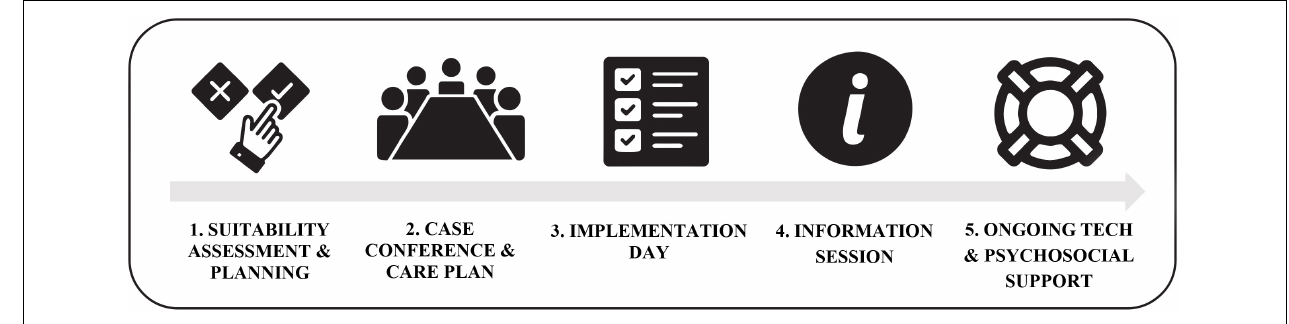
FIGURE 2 | Components of and progression through the telepresence robot